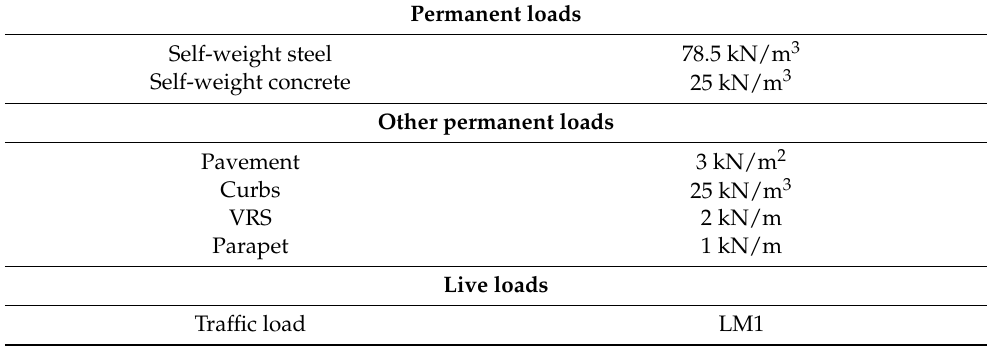
Table 3. Load cases.